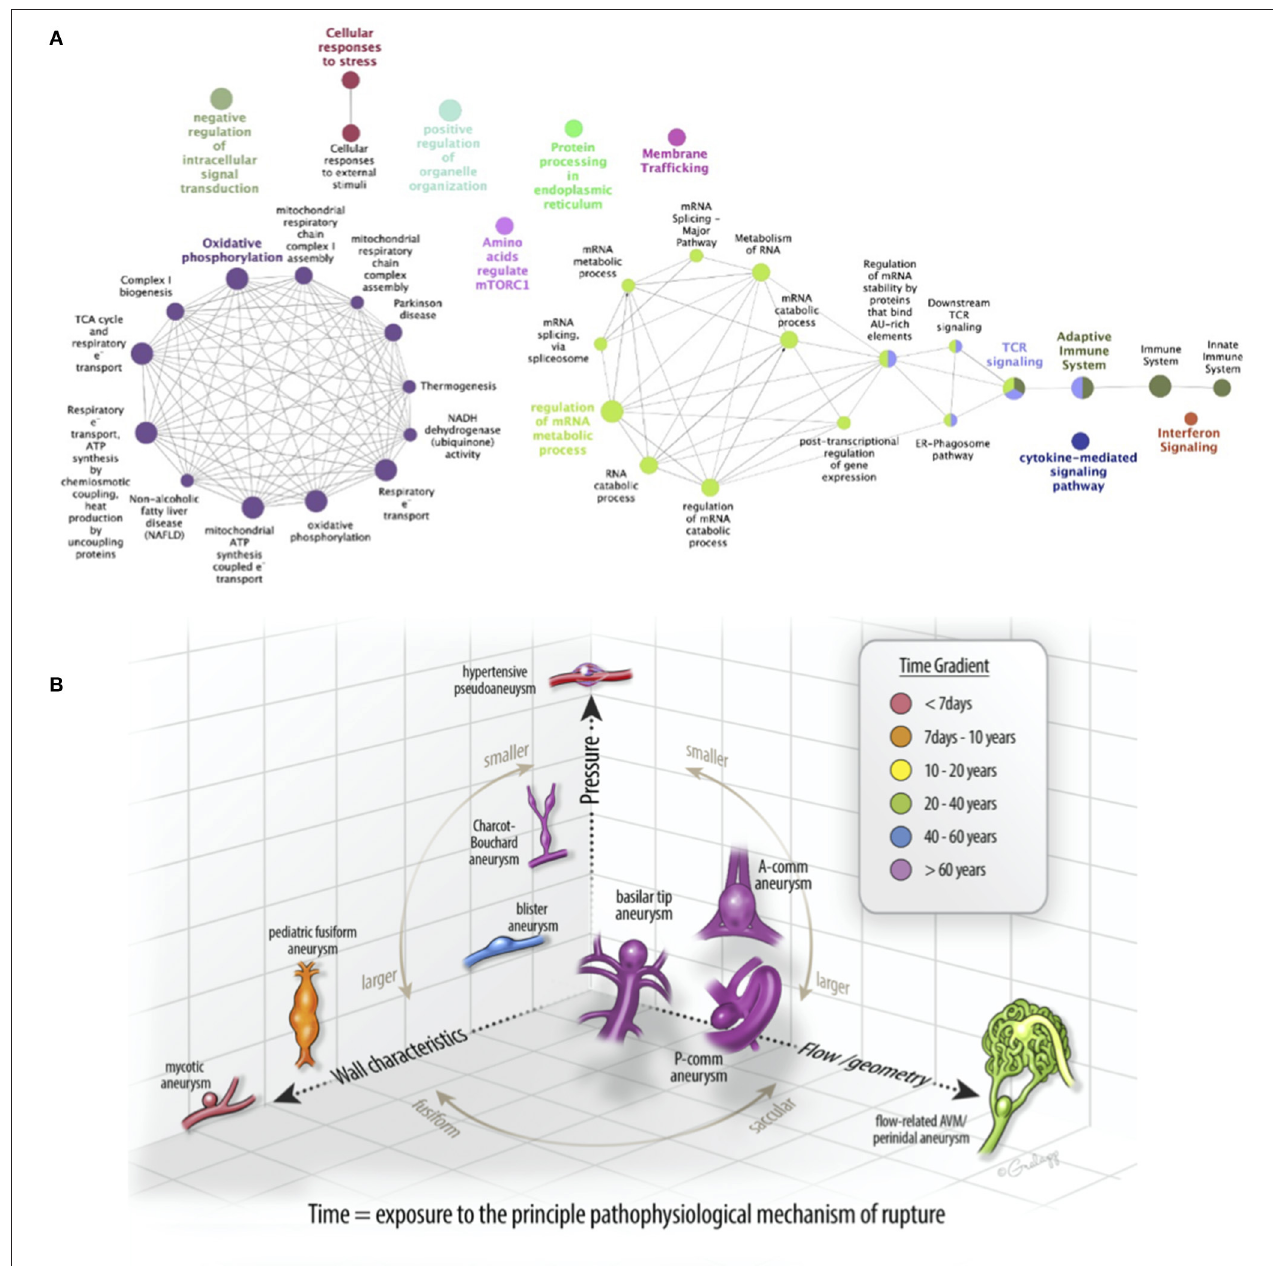
FIGURE 5 | A patient-specific disease pathogenesis can be inferred from the endovascular biopsy results. (A) Significantly enriched pathways identified in the protein–protein interaction network were functionally grouped using clueGO to facilitate biologic interpretation. The innate immune system, adaptive immune system, interferon signaling, and cytokine-mediated signaling nodes to the far right are linked to mRNA regulation via T-cell receptor (TCR) signaling. (B) A schematic diagram of commonly diagnosed intracranial aneurysms in a three-dimensional space composed of principal pathophysiologic axes. X -axis corresponds to flow/geometry-driven pathology, best demonstrated in the flow-related arteriovenous malformation (AVM)-associated aneurysms. Y -axis corresponds to the wall characteristics, best demonstrated by “mycotic” or infectious aneurysms. Z -axis corresponds to pressure, best demonstrated by hypertensive or Charcot-Bouchard aneurysms. Most saccular aneurysms (e.g., A-comm, P-comm, and basilar tip) are driven pathophysiologically by a composite of these processes. Recognizing the diversity of the driving processes and elucidating them with gene expression profiling could advance our understanding of intracranial aneurysms.